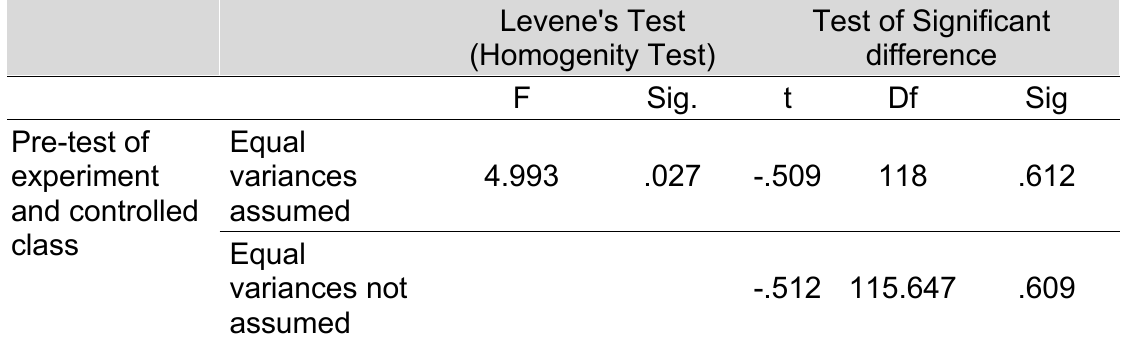
Table 4. Significance of pre-test between experiment and control class